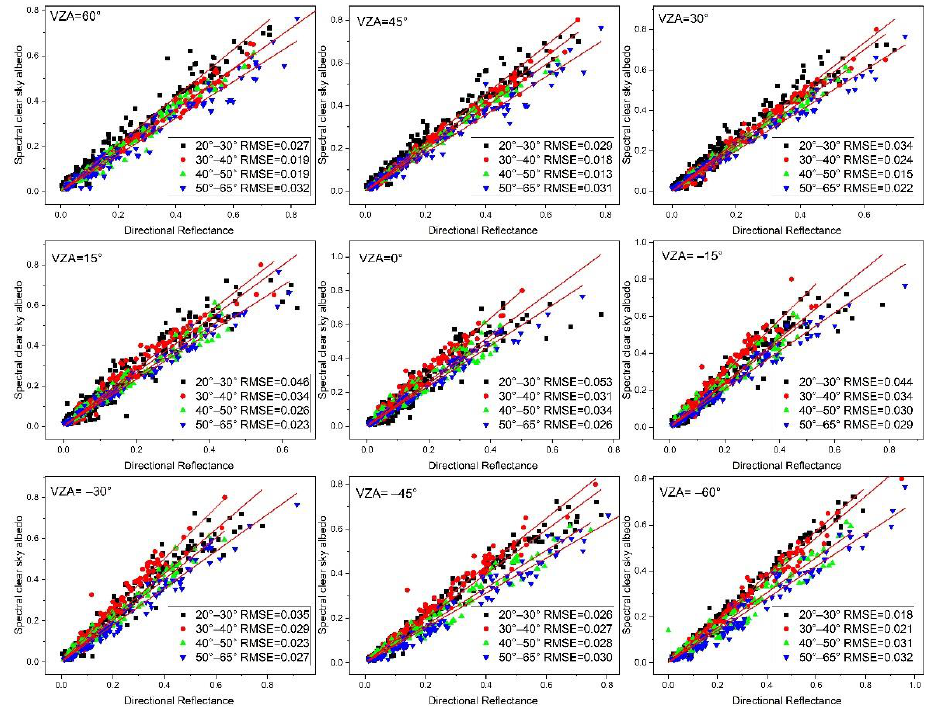
Figure 8. The SZA dependence for albedo conversion. Table 3. The R 2 values of SZA dependence.